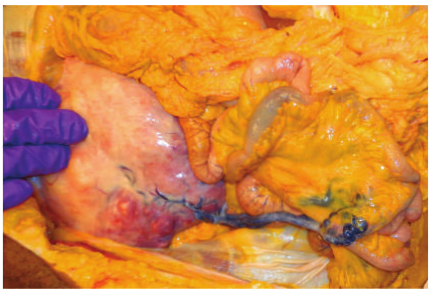
Figure 2: Vessel from the leiomyoma parasitizing to the mesentery.